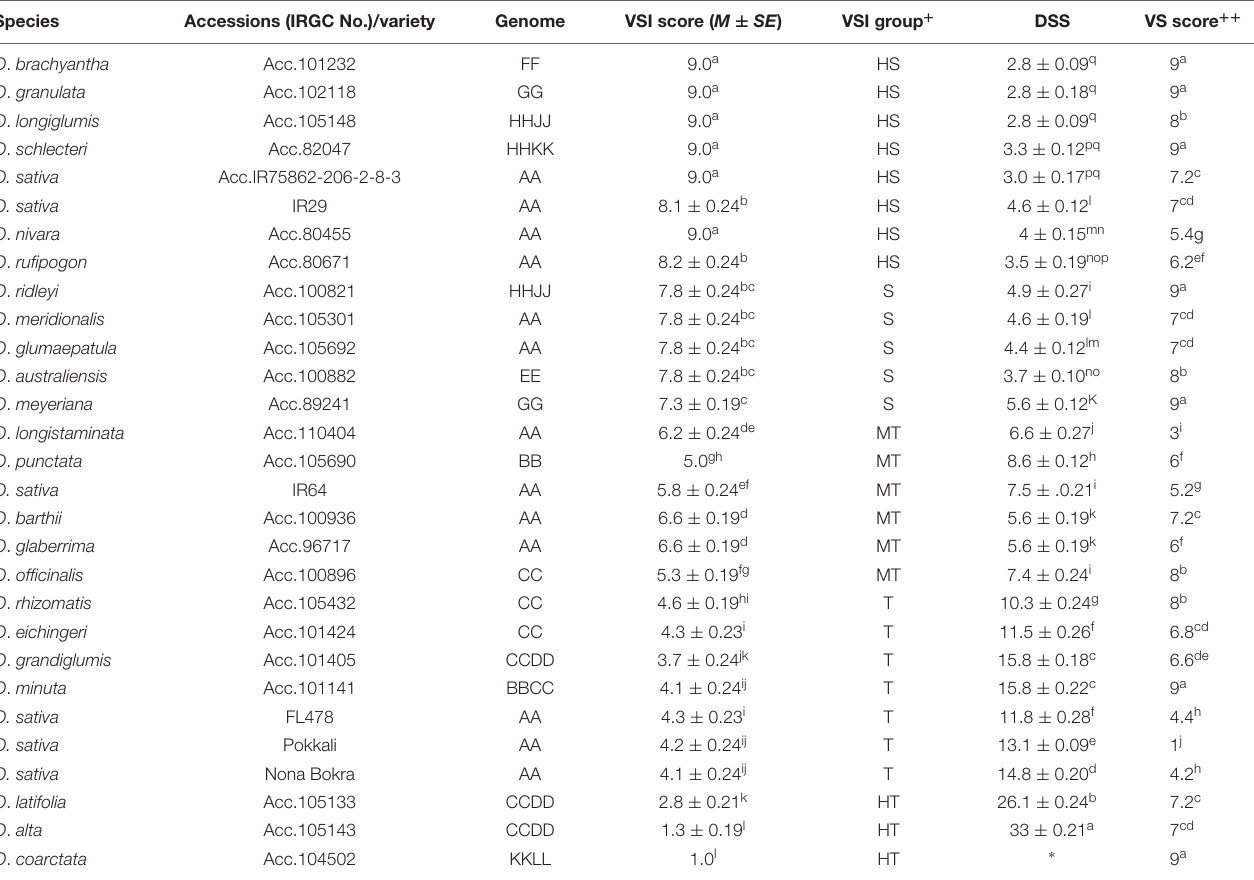
TABLE 1 | Salt stress phenotypes as determined by VSI score and days of seeding survival (DSS). Species Accessions (IRGC No.)/variety